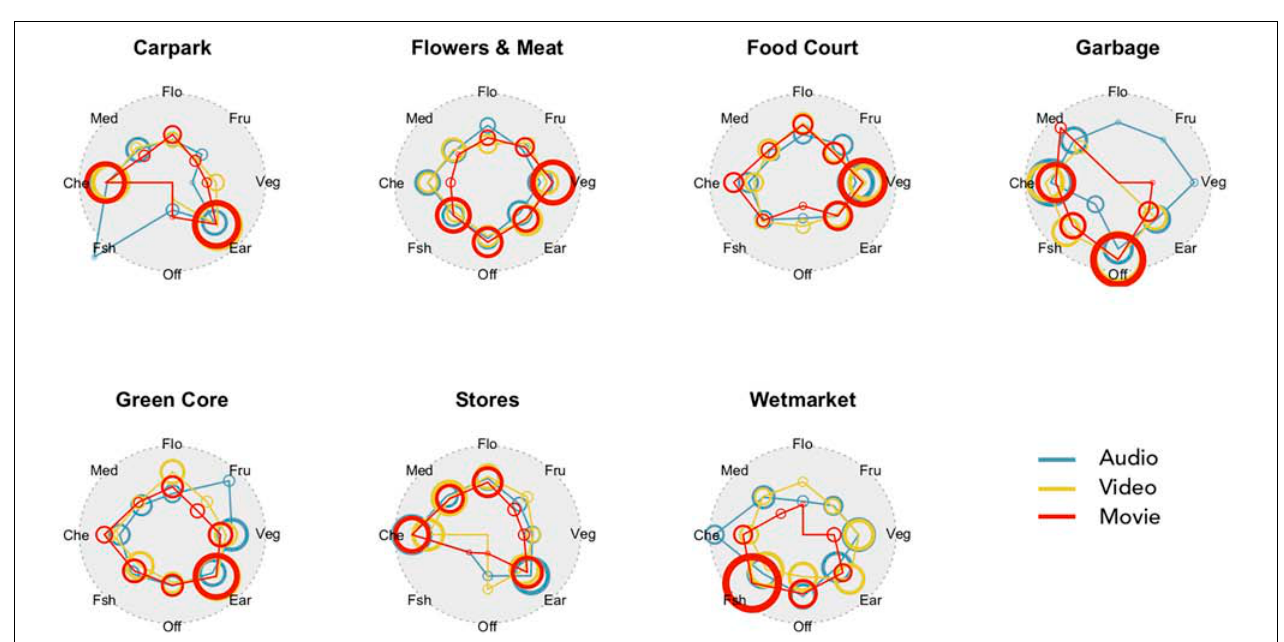
FIGURE 6 | Boxplots of ratings ( N = 53) of environmental quality in seven locations, as imagined when presented in three different audiovisual conditions. Quality was rated on a seven-step Likert scale; see the text for details.